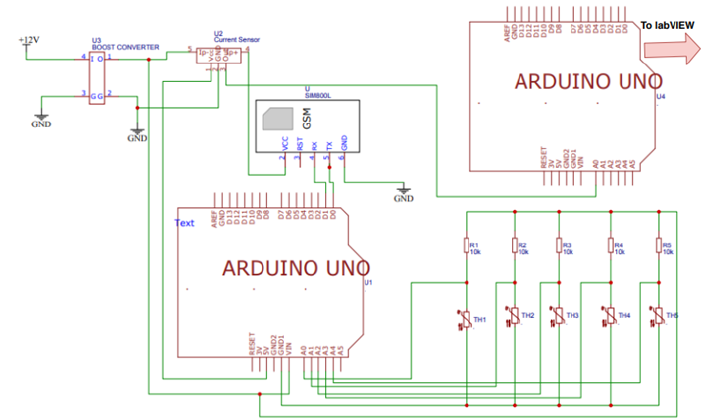
Figure 9. System schematic